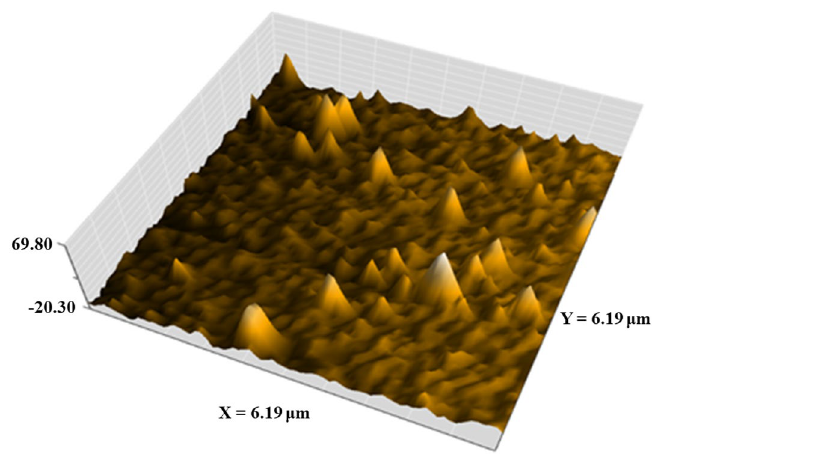
Figure 5. AFM images of